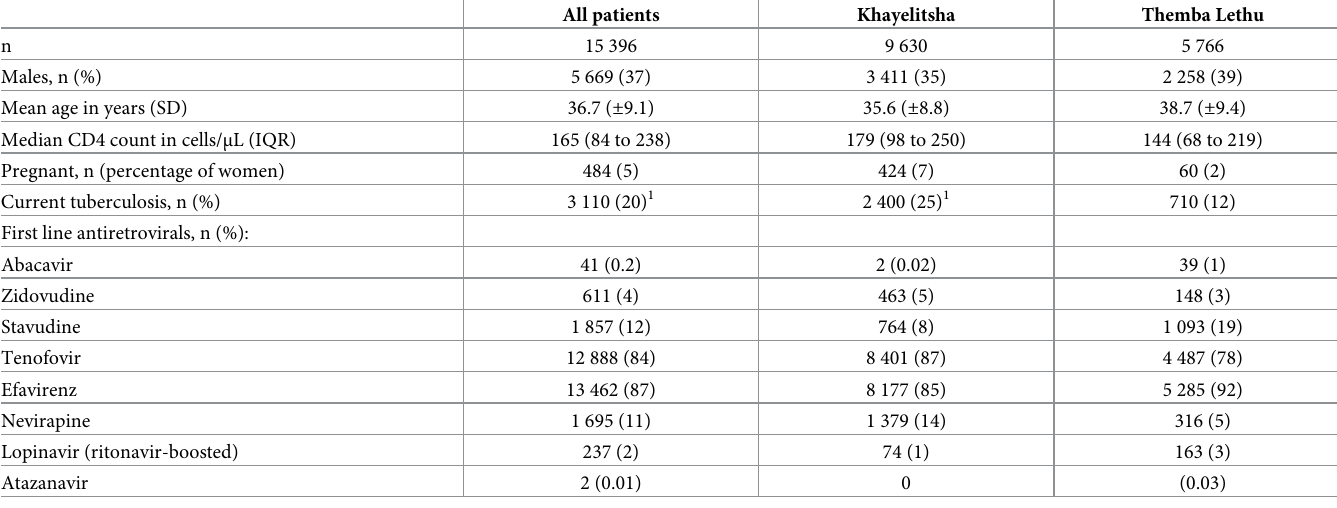
Table 1. Characteristics at first-line antiretroviral treatment initiation of adult patients from two South African cohorts, 2010–2013. All patients Khayelitsha Themba